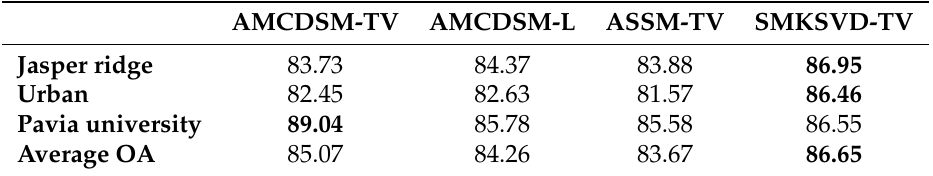
Table 13. The average overall accuracies for of the different data sets with obtained applying different